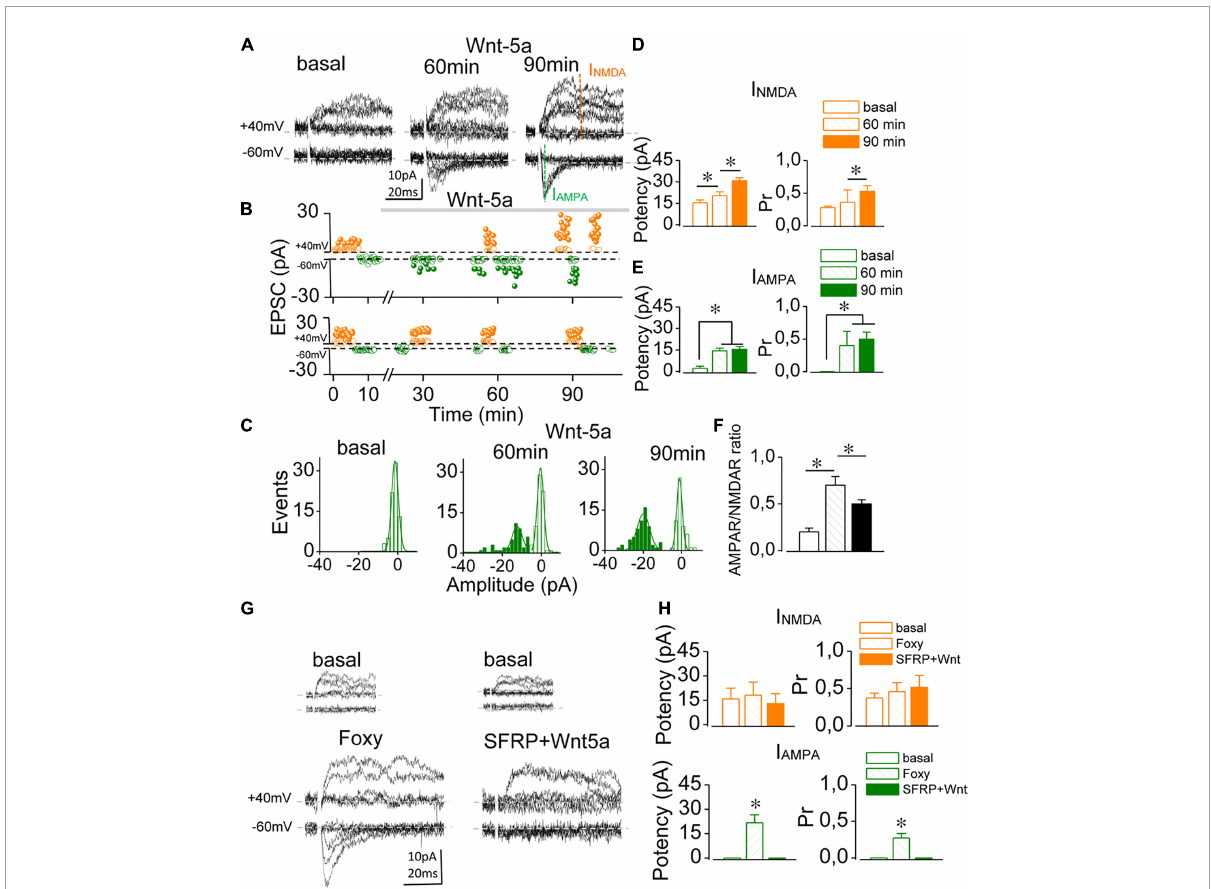
FIGURE1 Wnt-5a induces the functional conversion of single silent synapses. (A) Superimposed consecutive meEPSC traces (10 sweeps) recorded at –60 and + 40 mV in a single silent synapse before (basal) and 60 and 90 min after Wnt-5a perfusion. (B) Time course of the changes in meEPSC amplitude corresponding to failures (empty circles) and successes (solid circles), recorded at + 40 mV (orange) and –60 mV (green) of Hp in the presence of Wnt-5a (upper panel) and ligand-free control (lower panel) . Note that from 30 min with the ligand some I AMPA begin to appear. (C) Representative cumulative histogram of meEPSC amplitude at –60 mV before (basal) and after 60 and 90 min of Wnt-5a perfusion showing failures (white bars) and successes (green bars). (D,E) The average change in synaptic potency and the Pr at baseline and after 60 and 90 min of Wnt-5a at + 40 mV (orange bars) and –60 mV (green bars). (F) Average change in the I AMPAR /I NMDAR ratio obtained at baseline and after Wnt-5a perfusion. (G) Superimposed meEPSC traces recorded at –60 and + 40 mV from two representative silent synapses before (insert) and 60 min after Foxy-5 perfusion (left) or sFRP-2 plus Wnt-5a (right) . (H) The average change in synaptic potency and the Pr at baseline and 60 mV after Foxy-5 or sFRP-2 plus Wnt-5a treatment was at + 40 mV (orange bars) and –60 mV (green bars). Statistics: Error bars indicate ± SEM, one-way ANOVA test ( ∗ p <